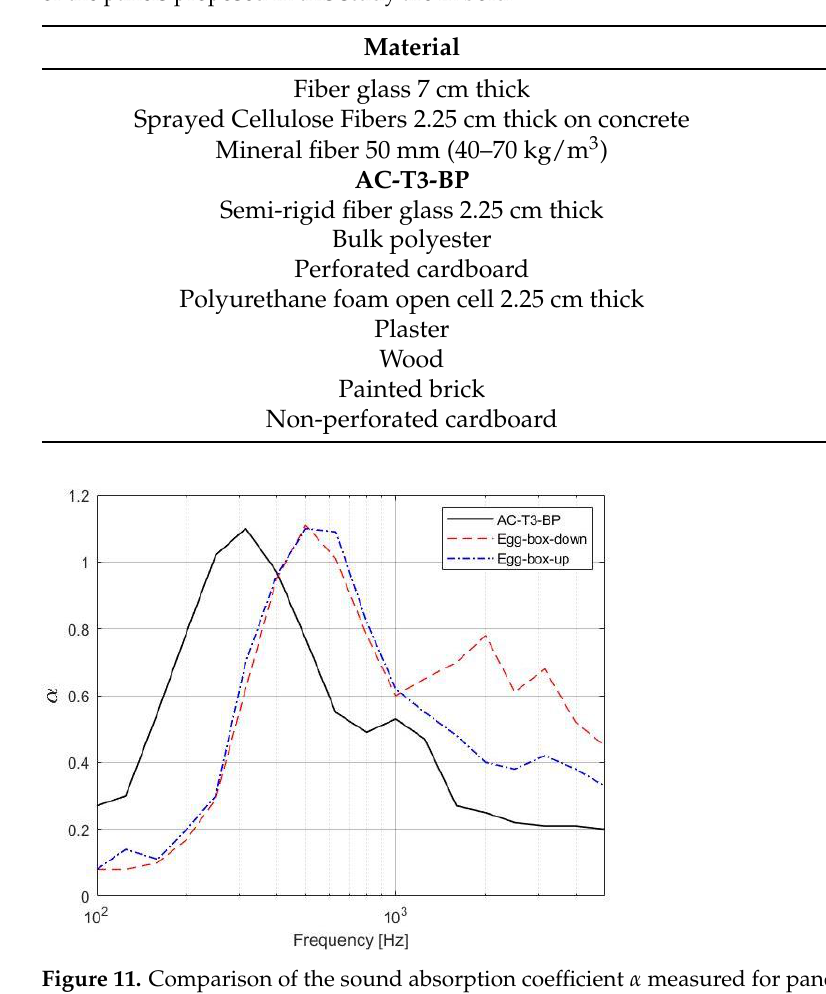
Table 4. Comparison of NRC of several materials employed in the building sector [52]. The properties of the panels proposed in this study are in bold.